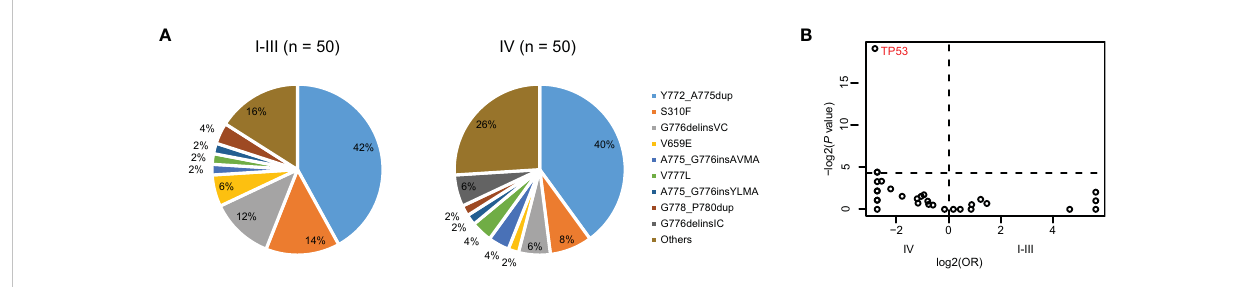
FIGURE 2 The differences of co-alteration pro fi le between early- and late-stage NSCLC with HER2 mutation. (A) Pie plot showing the incidence of HER2 mutation types within early- ( n = 50) and late-stage NSCLC ( n = 50) with HER2 mutation. (B) Volcano plots showing the difference of co-occurring alterations between early- and late-stage NSCLC with HER2